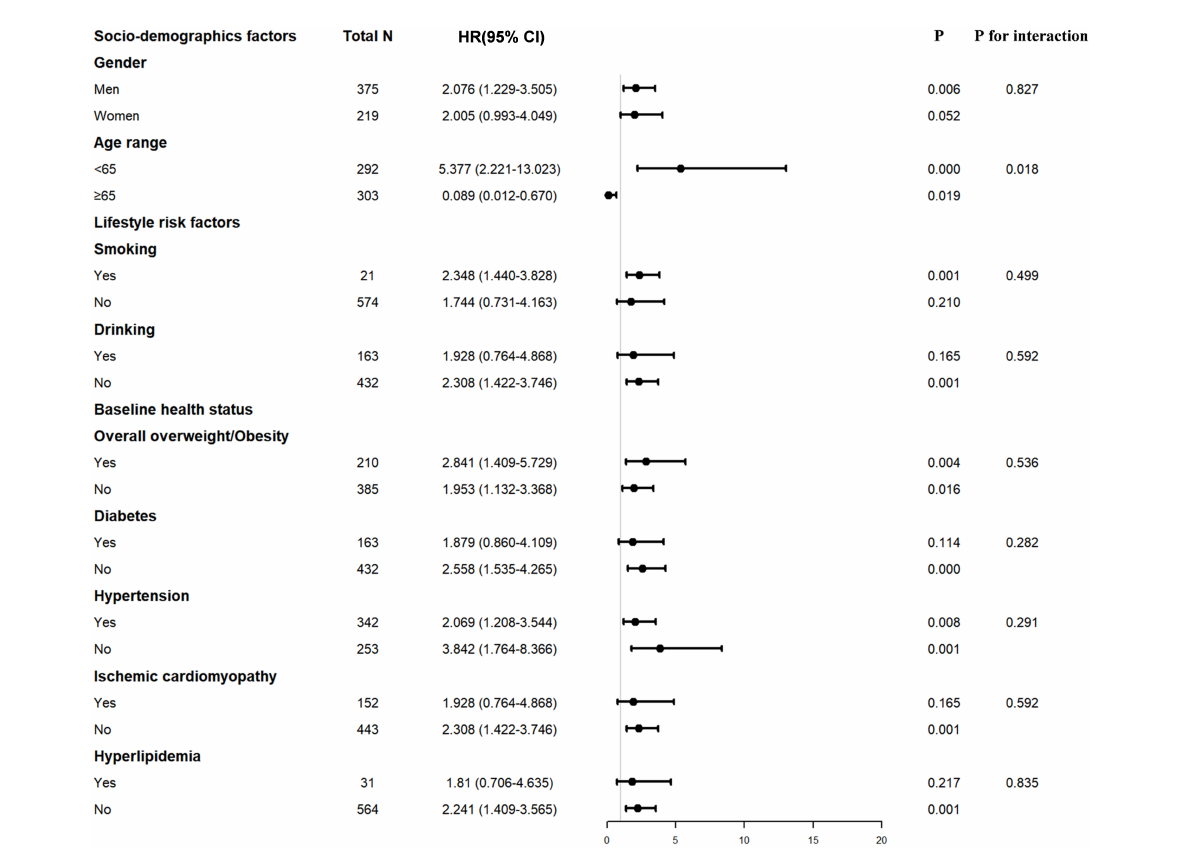
FIGURE3 Interaction of confounding factors on the association between (cid:49) GNRI and major adverse cardiovascular event (MCE) risk. GNRI, geriatric nutritional risk